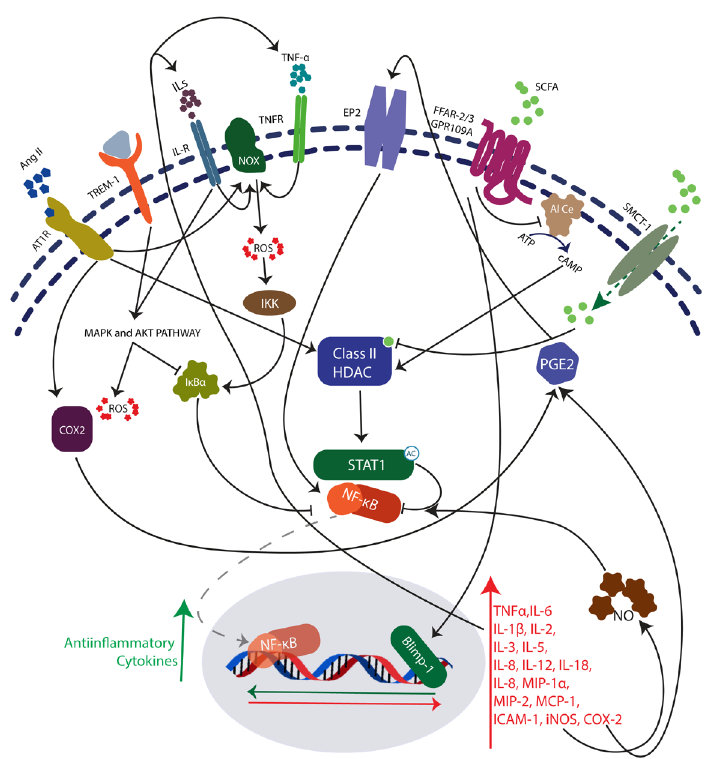
Figure 1. Proinflammatory Angiotensin II, Interleukins, Tumour necrosis factor-α and Triggering receptor expressed on myeloid cells 1 (TREM-1) mediates the activation of Mitogen-activated protein kinase (MAPK), Extracellular signal-regulated kinase (ERK1/2) and Phosphatidylinositol 3-kinase (PI3K)/protein kinase B (AKT) intracellular signalling pathways. The downstream activators of these pathways induces the reactive oxygen species (ROS) generation and transcription factor, NF-κB dependent expression of proinflammatory molecules. HDACs, which deacetylates Signal transducer and activator of transcription 1 (STAT1), and promotes the nuclear translocation and subsequent activity of NF-κB. Target genes of NF-κB, inducible nitric oxide synthase (iNOS) and cyclooxygenase-2 increases the NF-κB activity via positive feedback loop. Histone deacetylase (HDAC) inhibitor, butyrate mediates its effects through GPCRs: Free fatty acid receptors 2/3 and GPCR 109A or by directly binding to HDAC active sites. Inhibition of NF-κB activity by butyrate